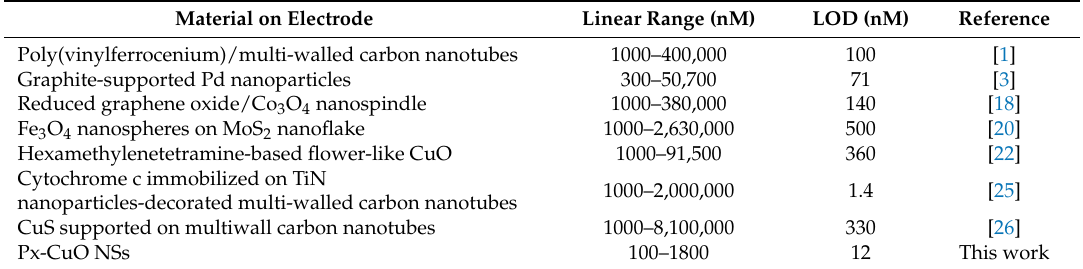
Table 1. Comparative data for nitrite detection using electrodes modified with different materials.